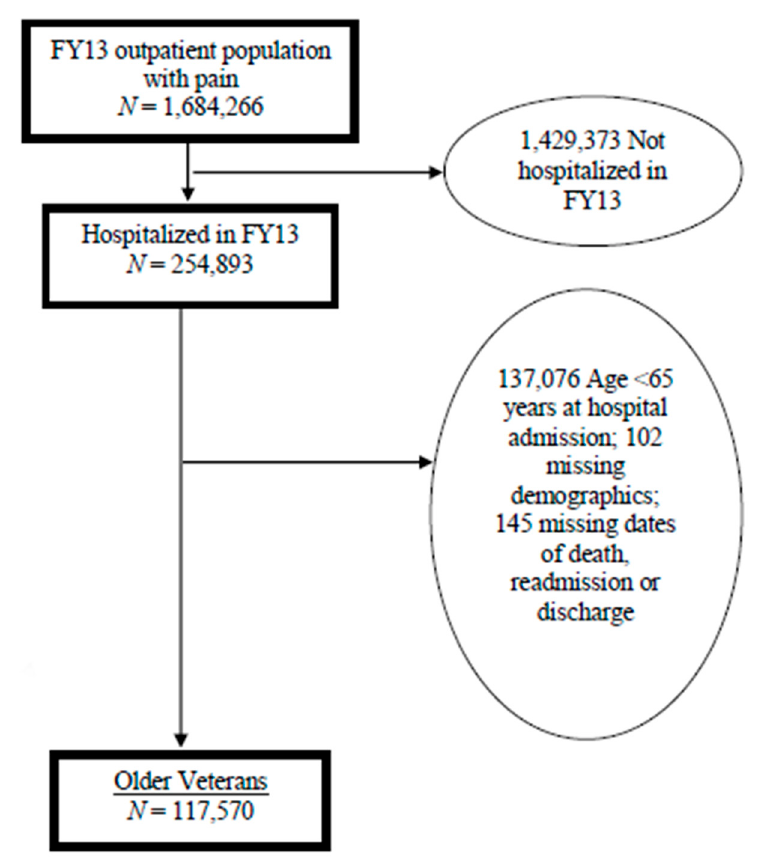
Figure 2. A flowchart for analytic cohort. Table 1. Characteristics of US veterans with chronic pain prior to hospital admission during fiscal year 2013: in overall sample and according to pain intensity* ( N = 96,224).